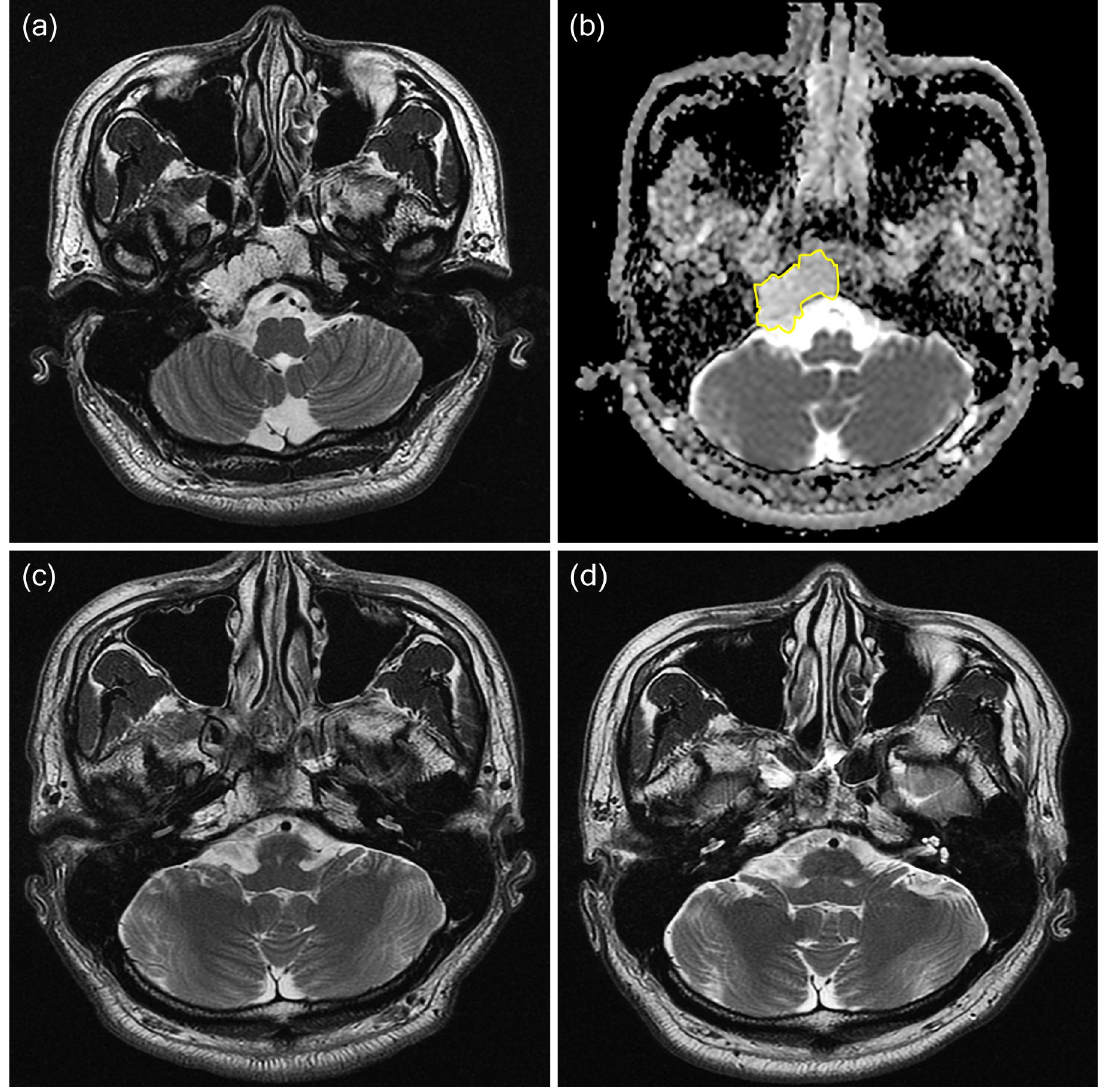
Figure 5. A 36-year-old man diagnosed with classic chordoma and placed in the stable group. ( a ) Preoperative T2-weighted imaging showed a T2 high signal mass arising from the clivus. ( b ) The ROI is outlined in yellow on the ADC map and represents moderate water diffusivity (mean ADC 1659 × 10 –6 mm 2 /s, minimum ADC 1386 × 10 –6 mm 2 /s). ( c ) Immediate postoperative T2-weighted imaging showed partial tumor removal. The operation was performed via the transsphenoidal approach. ( d ) T2-weighted follow-up imaging obtained 7 years later showed stable disease. The patient received conventional radiotherapy (62.5 Gy) 1 month after the first